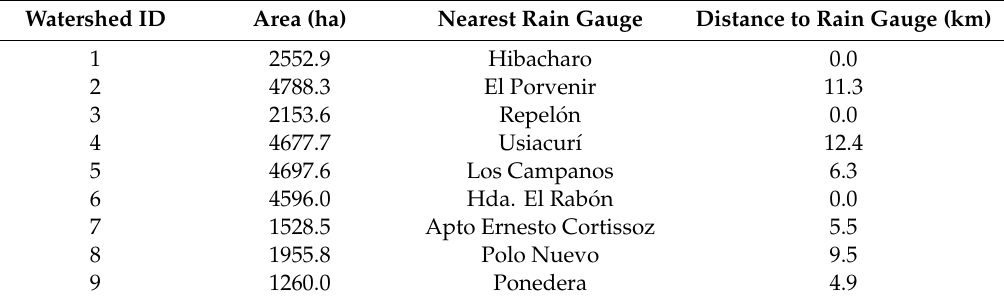
Table 9. Information about watershed used. ID—identifier.